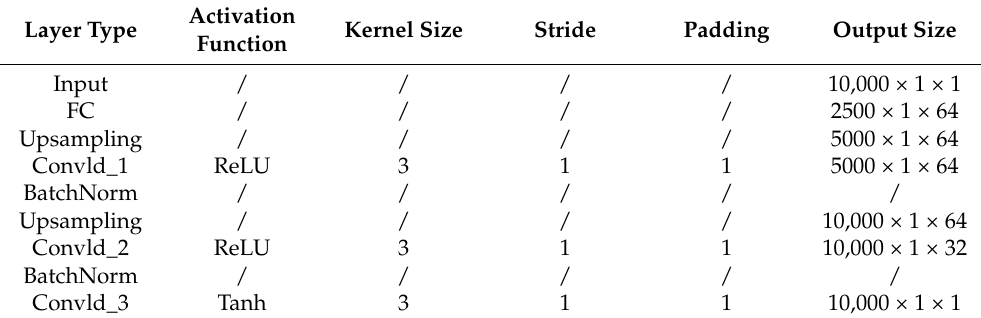
Table 1. Detailed parameters for generator G.